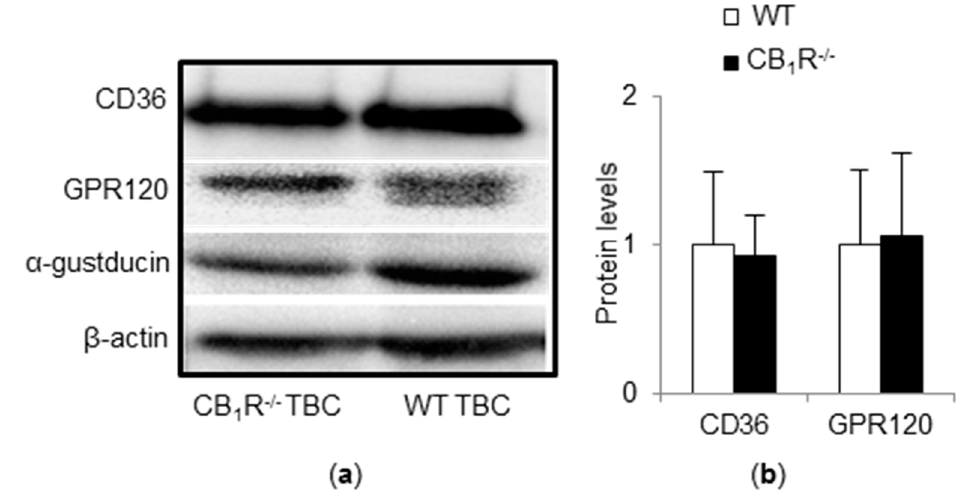
Figure 3. Impact of CB 1 R gene invalidation on CD36 and GPR120 protein expressions. CD36 and GPR120 protein levels were measured by Western blotting in taste bud cells (TBC) ( n = 2) from WT and CB 1 R − / − mice. ( a ) A representative blot corresponding to a pool of total proteins from four mice TBC is shown. ( b ) The corresponding histogram shows CD36 and GPR120 protein levels. Values are expressed as mean ± SD ( n = 2).